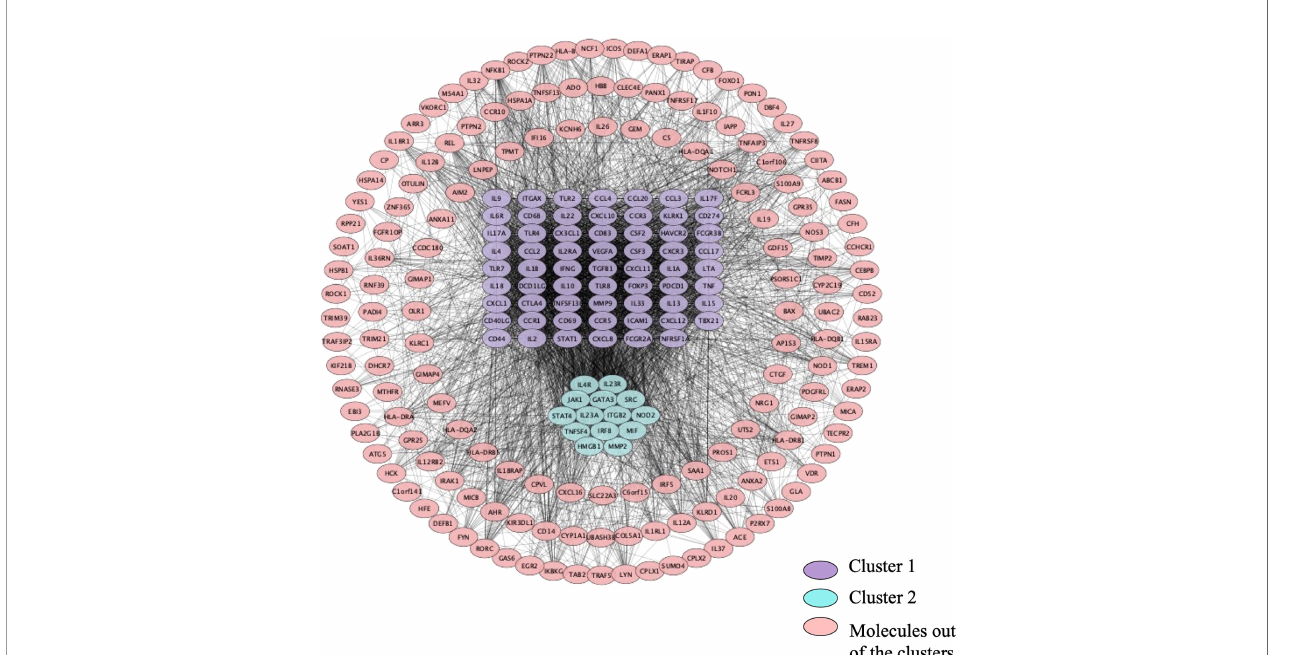
FIGURE 4 | The PPI network. 246 nodes and 3946 edges were involved in the PPI network. Cluster 1 contains 62 nodes indicated in purple, and cluster 2 contains 14 nodes indicated in turquoise. Molecules in pink are not in any cluster.